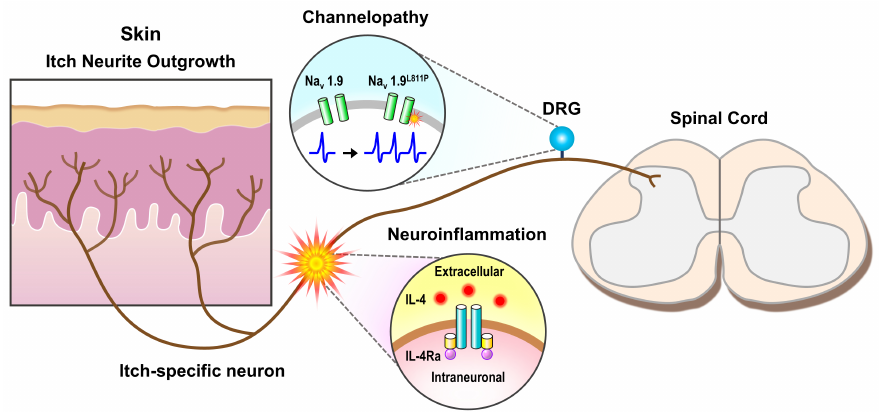
Figure 1. Neuropathic itch of the peripheral nervous system. Small diameter itch-sensing nerves of the dorsal root ganglia (DRG) ramify in skin and synapse with secondary neurons in the outer laminar layers of the dorsal horn of the spinal cord. Various insults along this peripheral neuronal tract can result in neuropathic itch. These include increased neurite outgrowth in diseased skin, neuroinflammatory activation via IL-4 / IL-4Ra receptor, and genetic channelopathies such as Na v 1.9 L811P which has been associated with increased itch nerve